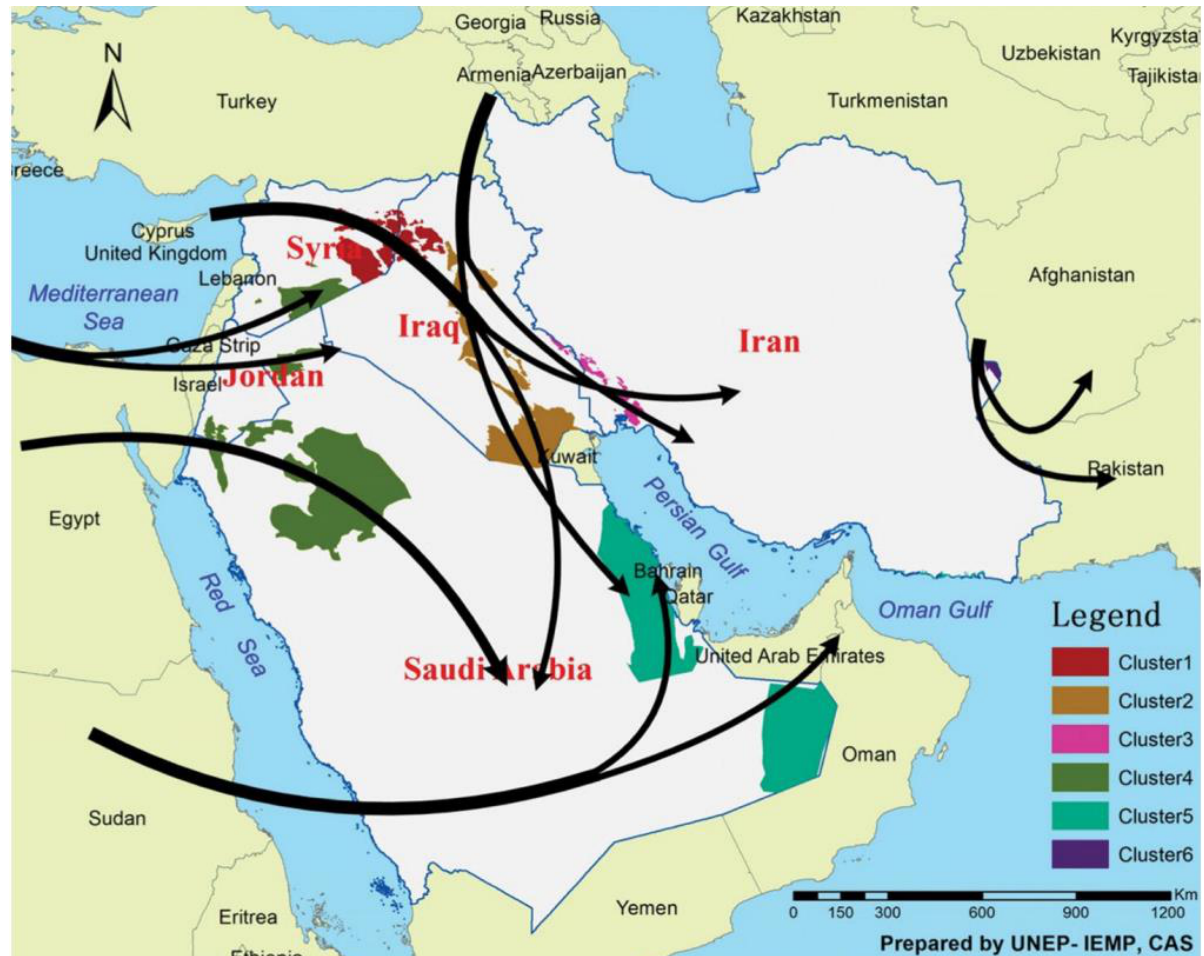
Figure 11. Paths and point sources of the SDSs in the MENA [52].